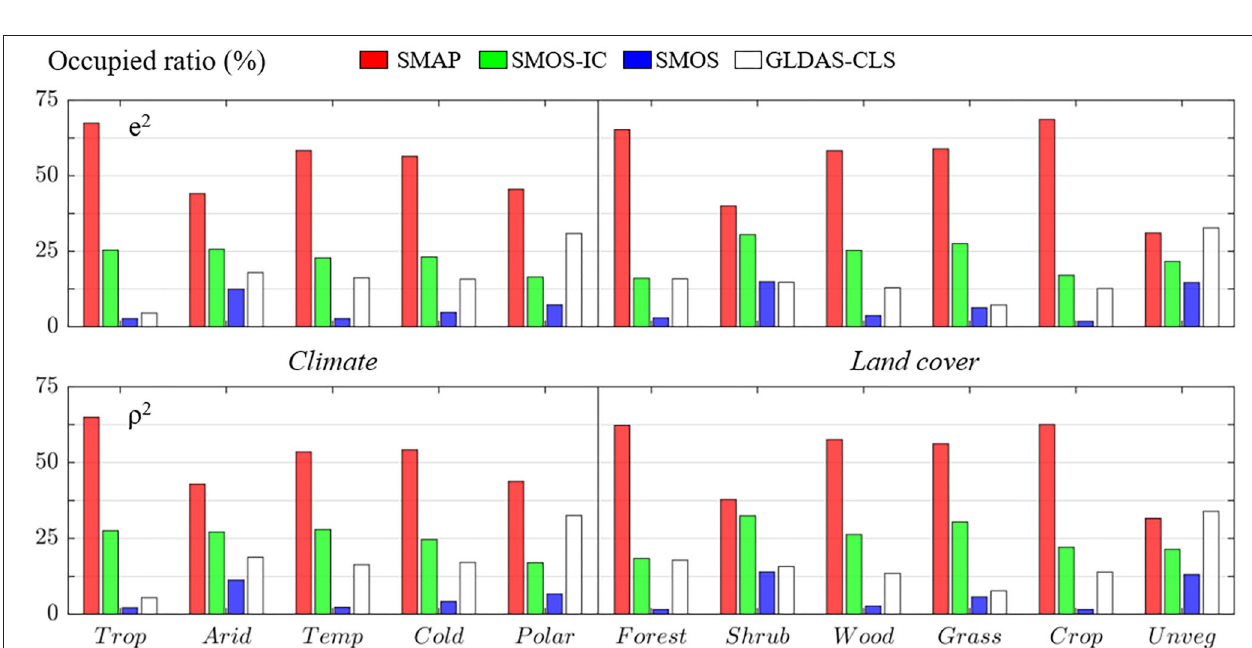
FIGURE 4 | Bar charts showing global occupied ratios in percentages of SMAP (red), SMOS-IC (green), SMOS (blue), and GLDAS-CLS (white) presenting the lowest error variances e 2 (Top) and the highest squared Pearson correlation coefficients ρ 2 (Bottom) for each climate or land cover class.